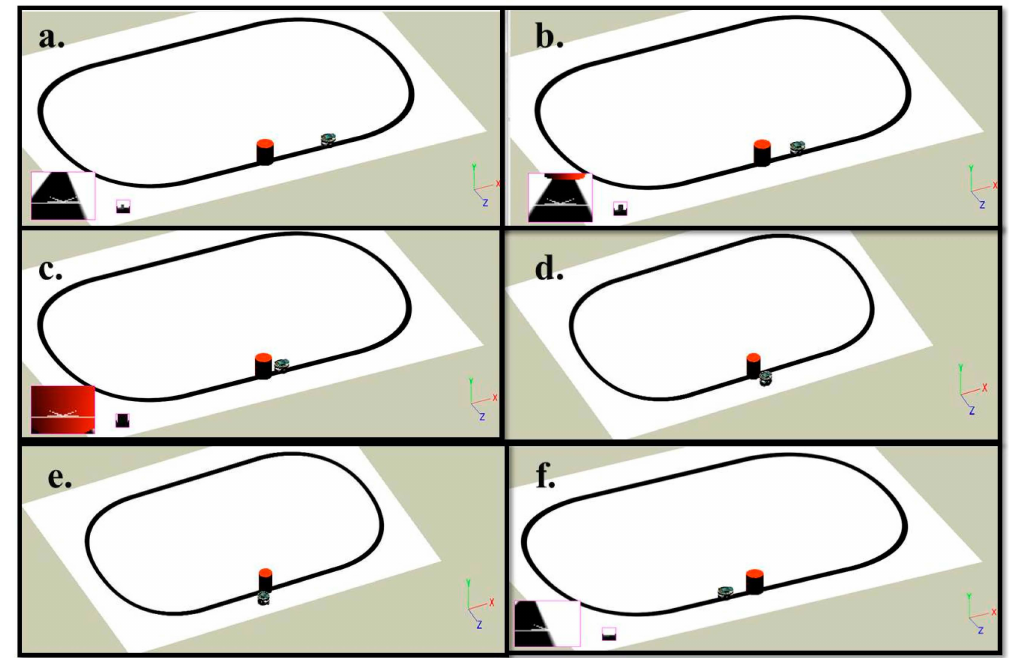
Figure 8. Simulation snapshots of one robot and one obstacle. ( a ) The beginning of the simulation; ( b ) The robot moves forward; ( c ) The robot detects an obstacle on its way; ( d ) The robot avoids the obstacle and turns left; ( e ) The robot tries to find the path again; ( f ) The robot continues following the line.